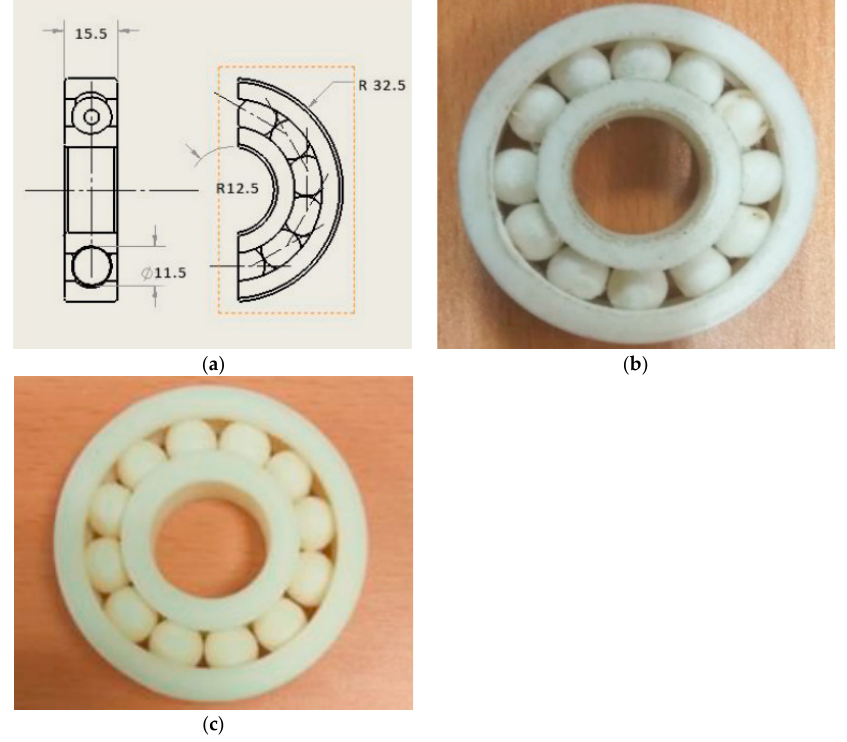
Figure 7. ( a ) 2D drawing of the assembly (dimensions in mm) and 3D-printed bearing using ( b ) Nylon 66 and ( c ) ABS (adapted with permission from reference [28]).